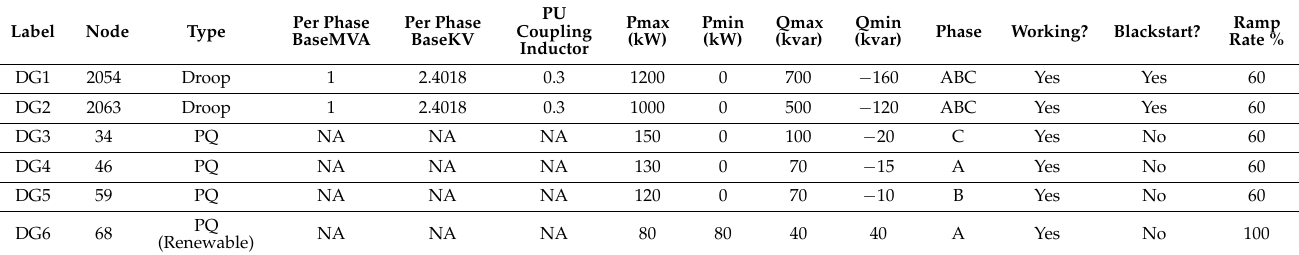
Figure 3. One-line diagram of the base test system before initiating restoration based on modified IEEE 123 node test feeder. Table 2. DG Parameters used for the Case